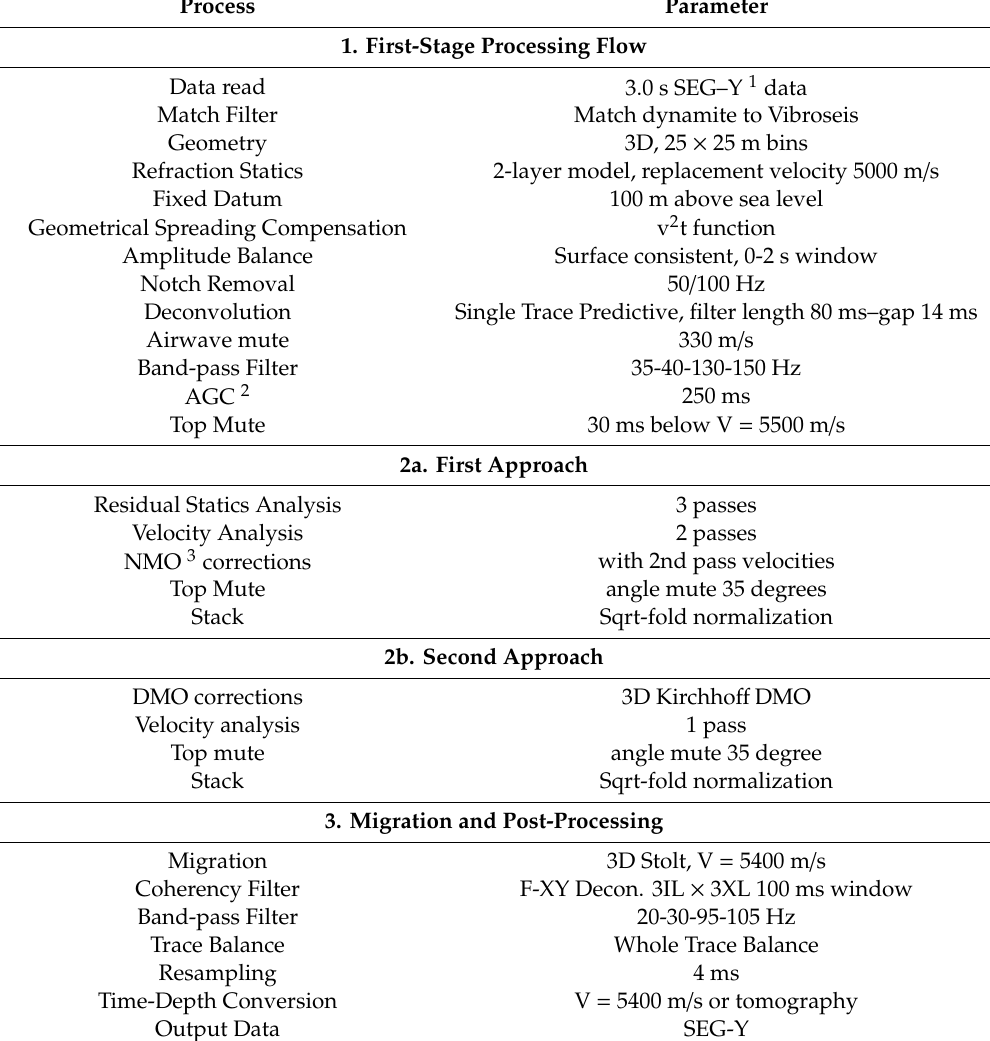
Table 2. Processing steps for COGITO-MIN 3D survey (dip moveout–post-stack time migration (DMO–PoSTM /